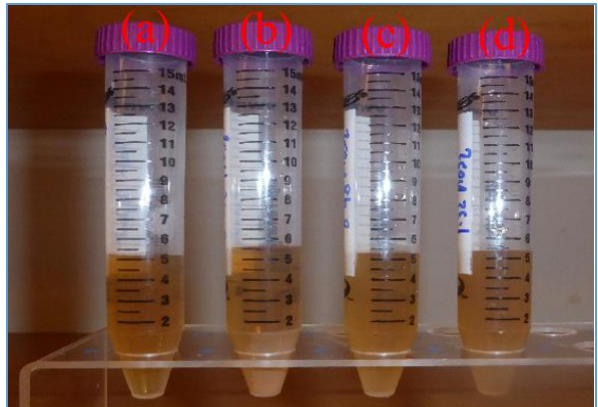
Figure 14. Drilling fluids (Filtrate loss): ( a ) Ref (5.2 mL), ( b ) Ref + 0.09 wt.% (5.5 mL) ( c ) Ref +0.19 wt.% (5.4 mL) ( d ) Ref + 0.26 wt.% (5.4 mL).